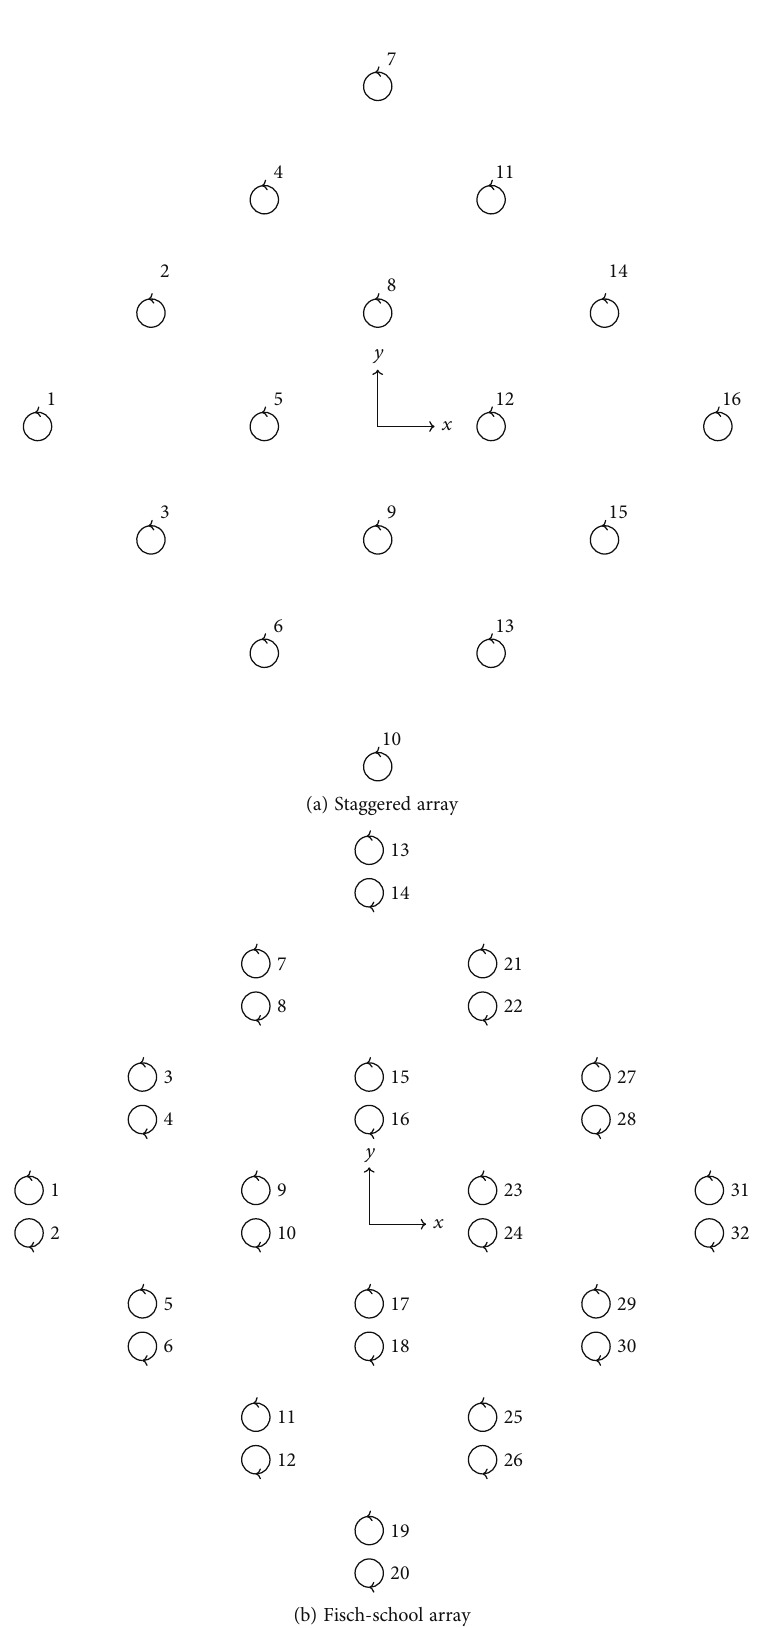
Figure 3: The two di ff erent arrays that will be used throughout this work. The fl ow is from left to